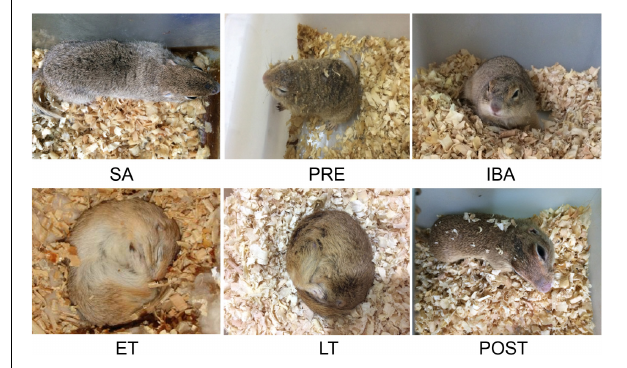
FIGURE 1 | Images of Daurian ground squirrels during different hibernation periods. SA, summer active; PRE, pre-hibernation; ET, early torpor; LT, late torpor; IBA, interbout arousals; POST, post-hibernation.